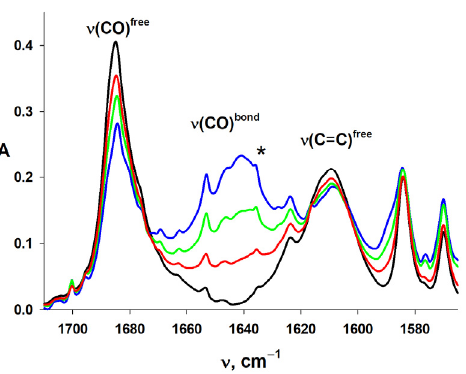
Figure 6. The IR spectra of chalcones Z- 1 , (c = 0.015 M, d = 1 mm, black line) in the presence of 0.5 (red), 1 (green), and 2 (blue) equivalents of [AgPz] 3 ; CCl 4 , 298 K. * δ (C-N) [AgPz]3.